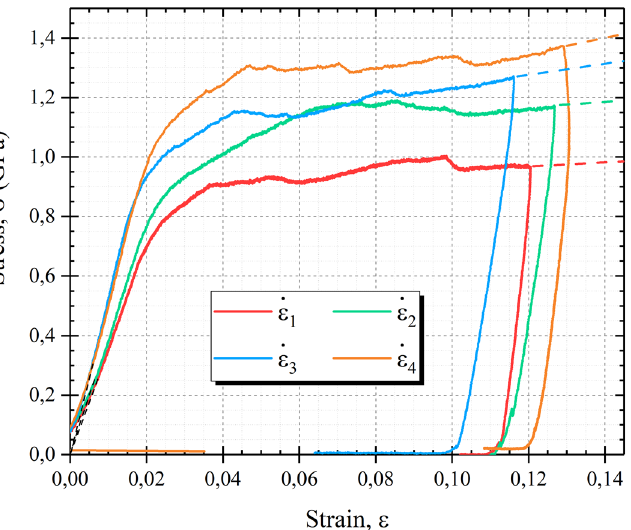
Figure 2. Stress–strain curves of InSb micro-pillars of 5 µm deformed by micro-compression with four constant strain rates (